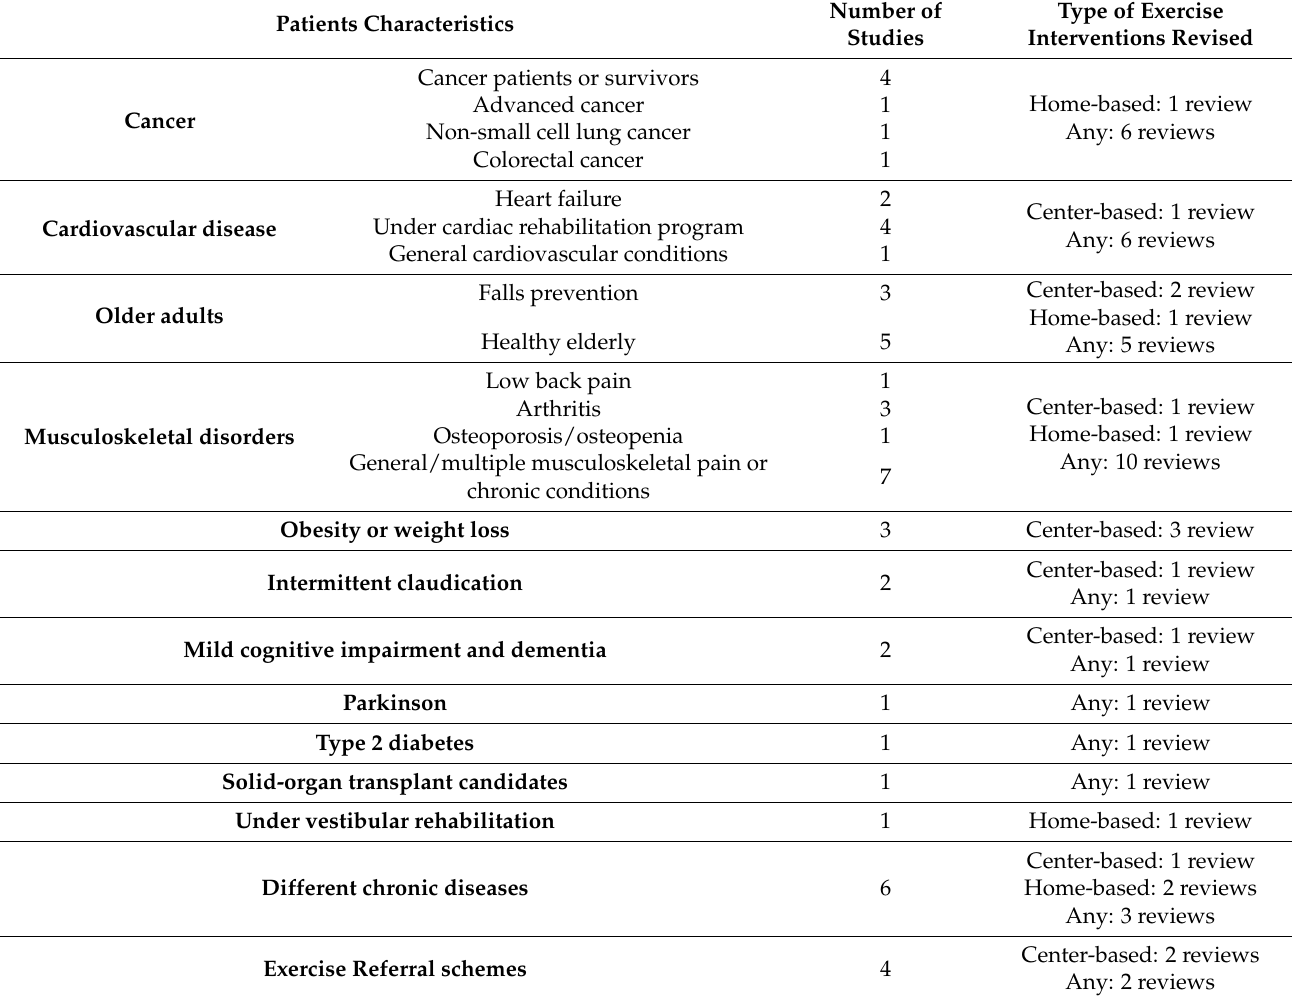
Table 1. Summary of the sample characteristics, type of exercise, and number of reviews identified for each sample and exercise